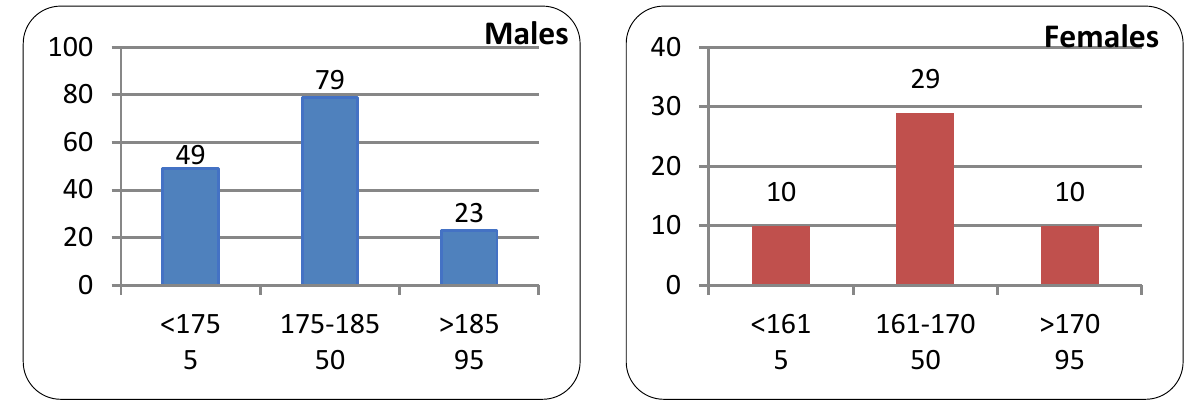
Figure 2. Sample structure in terms of height percentile groups and sex.